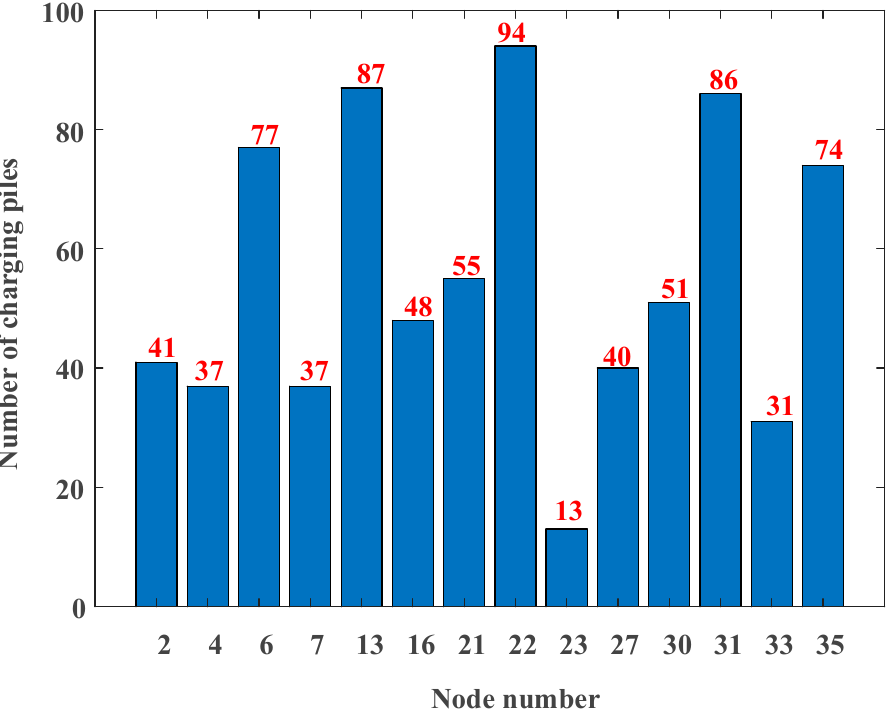
Figure 6. Charging pile optimal configuration results.